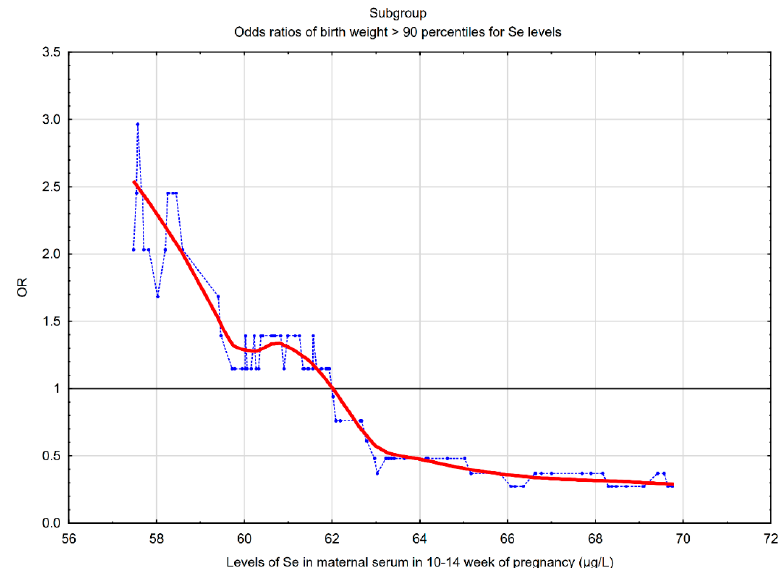
Figure 2. The risk of LGA birth weight ( > 90th percentile) for early pregnancy maternal serum selenium (Se) concentrations in the subgroup of women with the normal pre-pregnancy BMI (N = 145). The graph shows the changes in the odds ratio of LGA calculated on a sliding window with respect to the changes in the Se concentrations. The window width adopted was 30 observations. The blue points correspond to the odds ratios (OR) of LGA in a window containing a fixed number of neighboring cases (the center of the window is for a given value of Se concentration). The red curve represents the LGA risk profile smoothed with the Lowess method. The horizontal black line is the reference line for OR = 1; the points above the line indicate an increased risk.